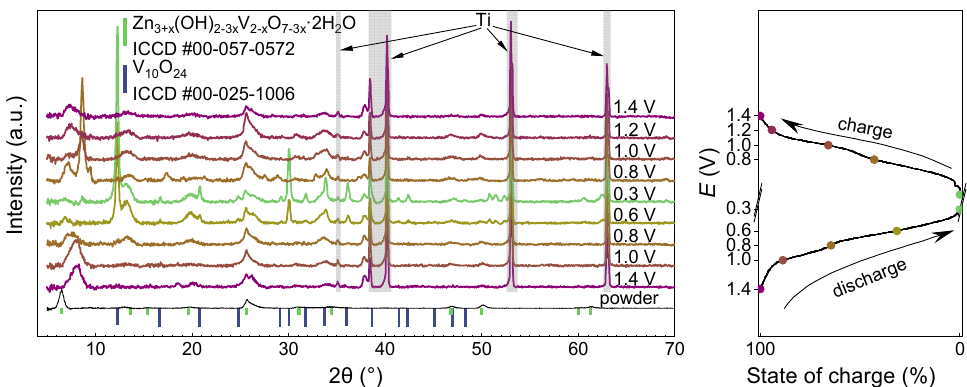
Figure 9. Ex situ XRD patterns of the VO@PEDOT electrode at various stages within the first discharge–charge cycle and the corresponding state-of-charge curve with the marked points of the potentials for XRD studies.